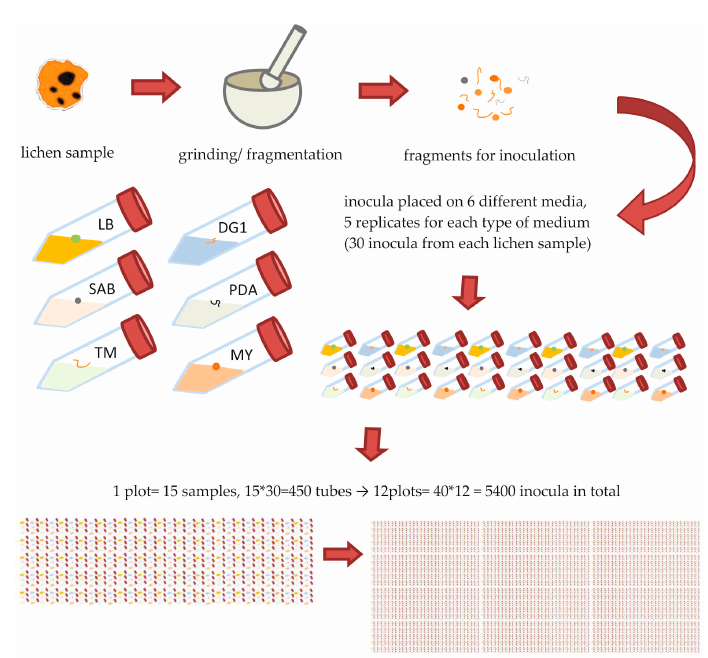
Figure A5. Workflow of the procedure used to set fungal isolates and replicates in the present research.